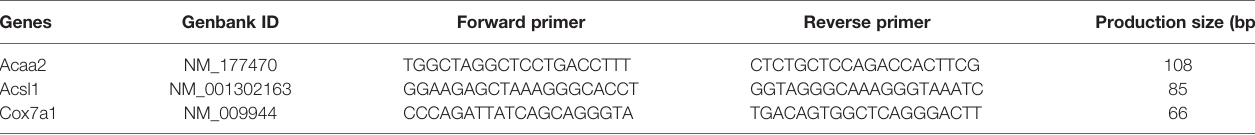
TABLE 1 | Primers for MeDIP qPCR.